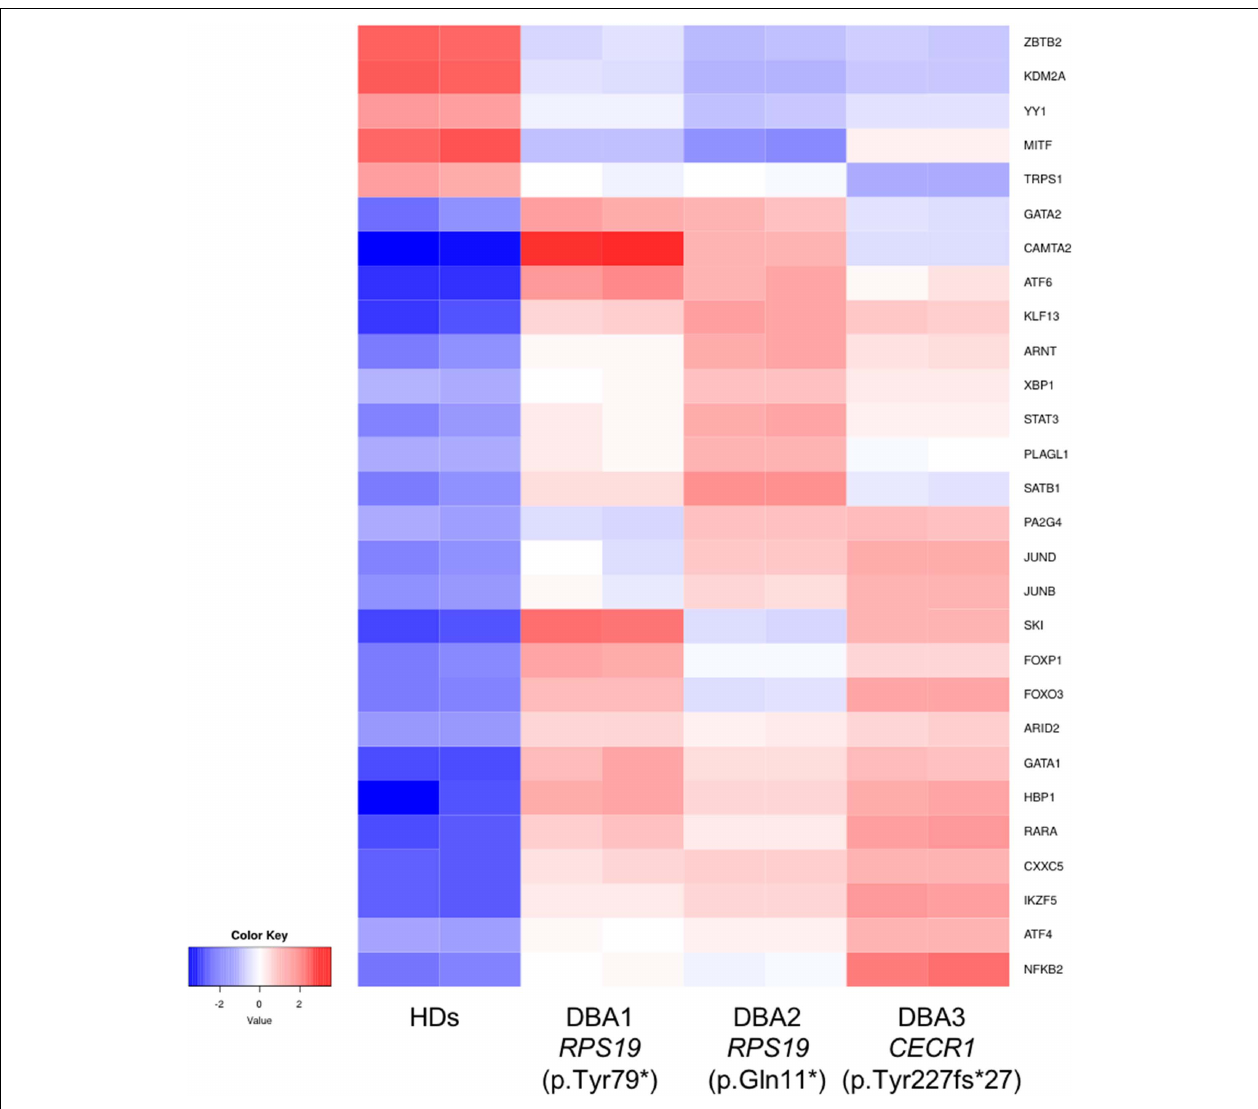
FIGURE 5 | Differentially expressed transcription factors that are primarily related with erythroid lineage or other critical cellular responses. HDs: healthy